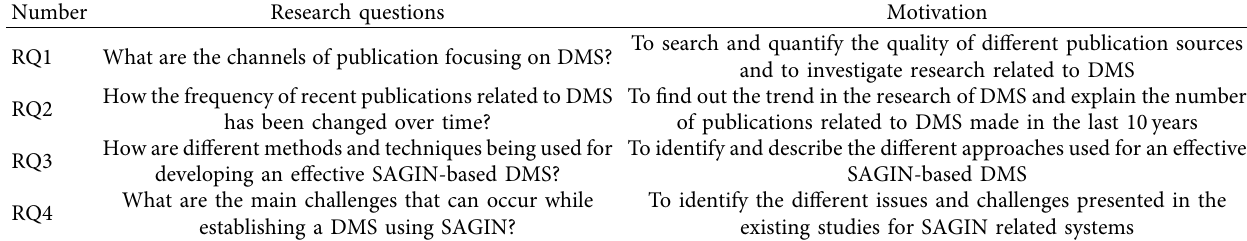
Table 2: Research question.